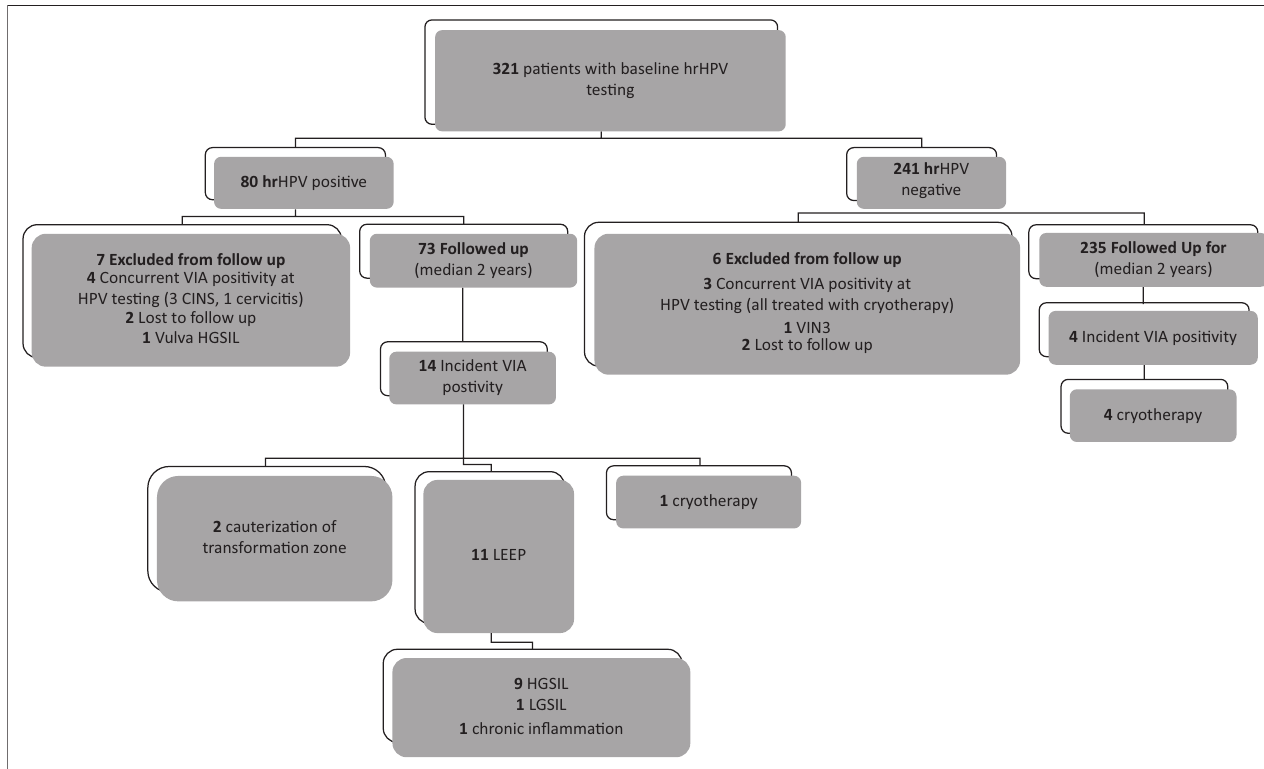
FIGURE 2: Visual inspection with acetic acid follow-up outcomes after baseline high-risk human papillomavirus